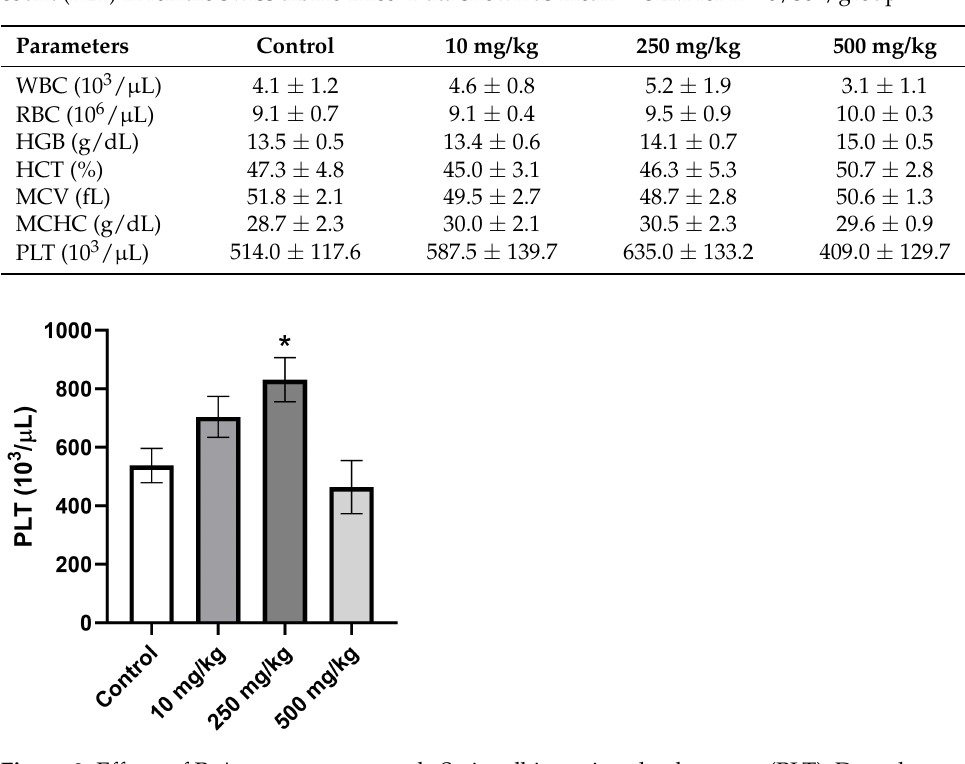
Figure 8. Effects of PsA treatments on male Swiss albino mice platelet count (PLT). Data shown as mean ± SEM for n = 5/group. * indicates a statistical significance at p < 0.05.